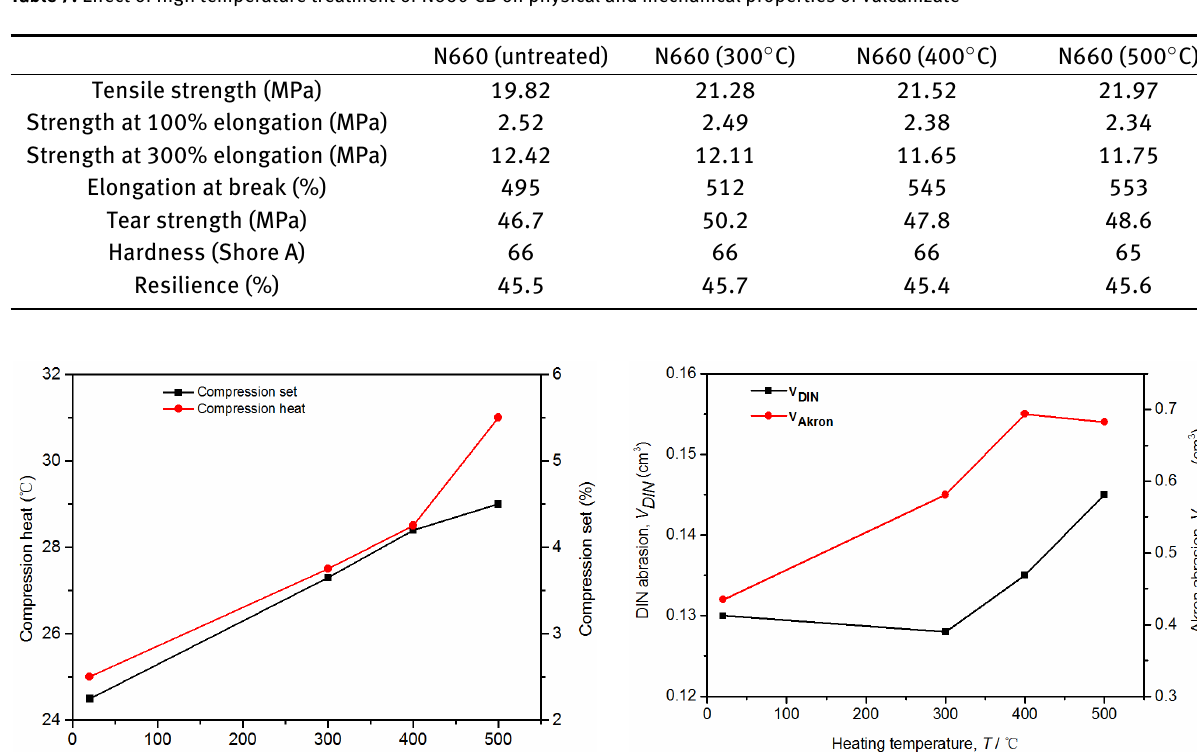
Table 7: Effect of high temperature treatment of N660 CB on physical and mechanical properties of vulcanizate